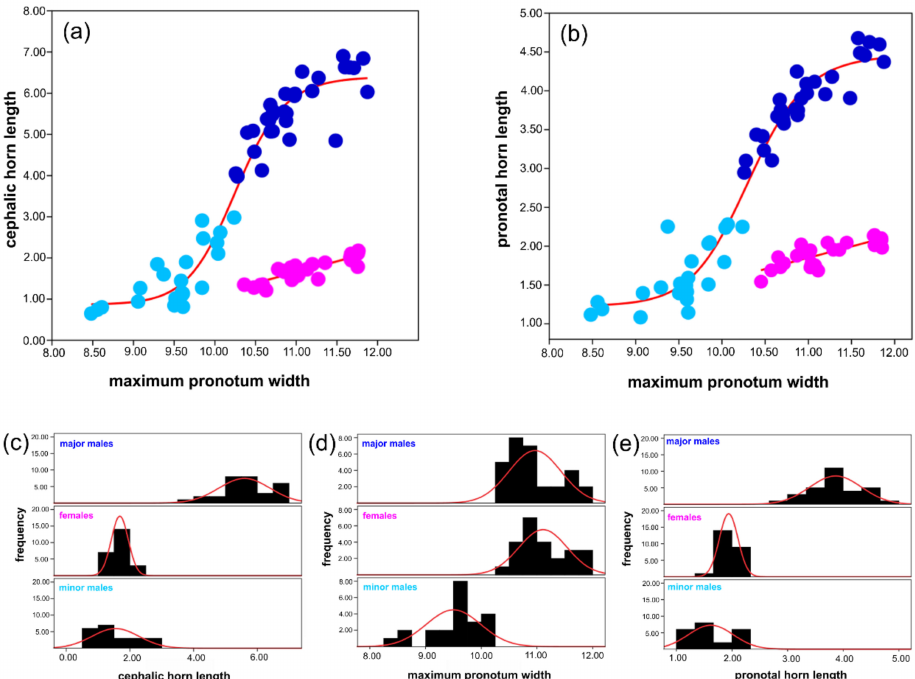
Figure 2. Horn allometry. ( a ) Scatterplot of the cephalic horn length and body size (i.e., maximum pronotum width). The best-fitting lines were showed on the plot for both sexes (red lines) separately, with the better AIC value being 18.285 for males (Hill’s sigmoid function) and 5.204 for females (linear function); ( b ) scatterplot of the pronotal horn length and body size (i.e., maximum pronotum width). The best-fitting lines were showed on the plot for both sexes (red lines) separately, with the better AIC value 11.775 being for males (Hill’s sigmoid function) and 4.807 for females (linear function). In both plots, the morphs were distinguished by dark blue (major males), light blue (minor males), and fuchsia (females) dots. Histograms of ( c ) cephalic horn length, ( d ) pronotum width, and ( e ) pronotal horn length frequency per morphs.